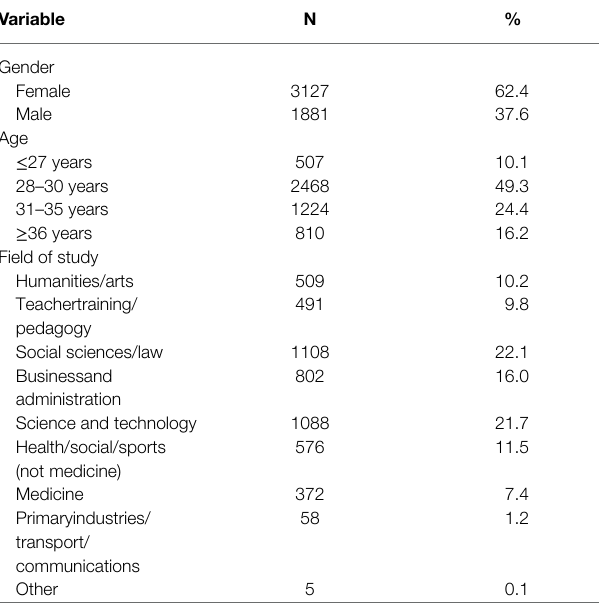
TABLE 1 | Characteristics of the study sample ( n = 5,009). TABLE 2 | Overview of items, item wordings, and response categories in the original version (TIPI) and the Norwegian translation